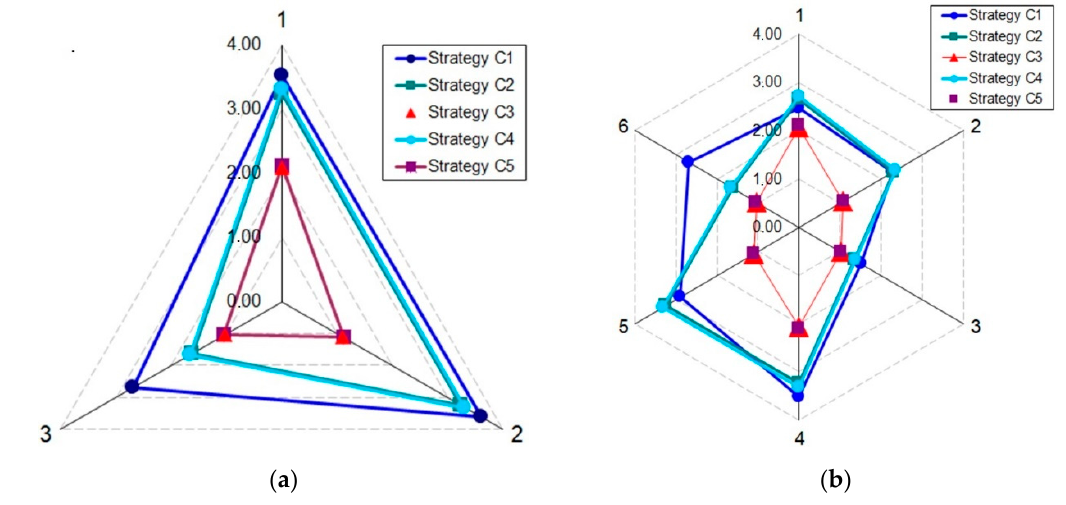
Figure 10. Ratios of the following parameters (strategies C1–C5) to the corresponding parameter of SCVM: ( a ) Peak-to-peak voltages across capacitors C 1 – C 3 , ( b ) rms (axes 1–3) and maximum values of currents in inductances L 1 – L 3 (axes 4–6). The results are based on the data in Table 3.